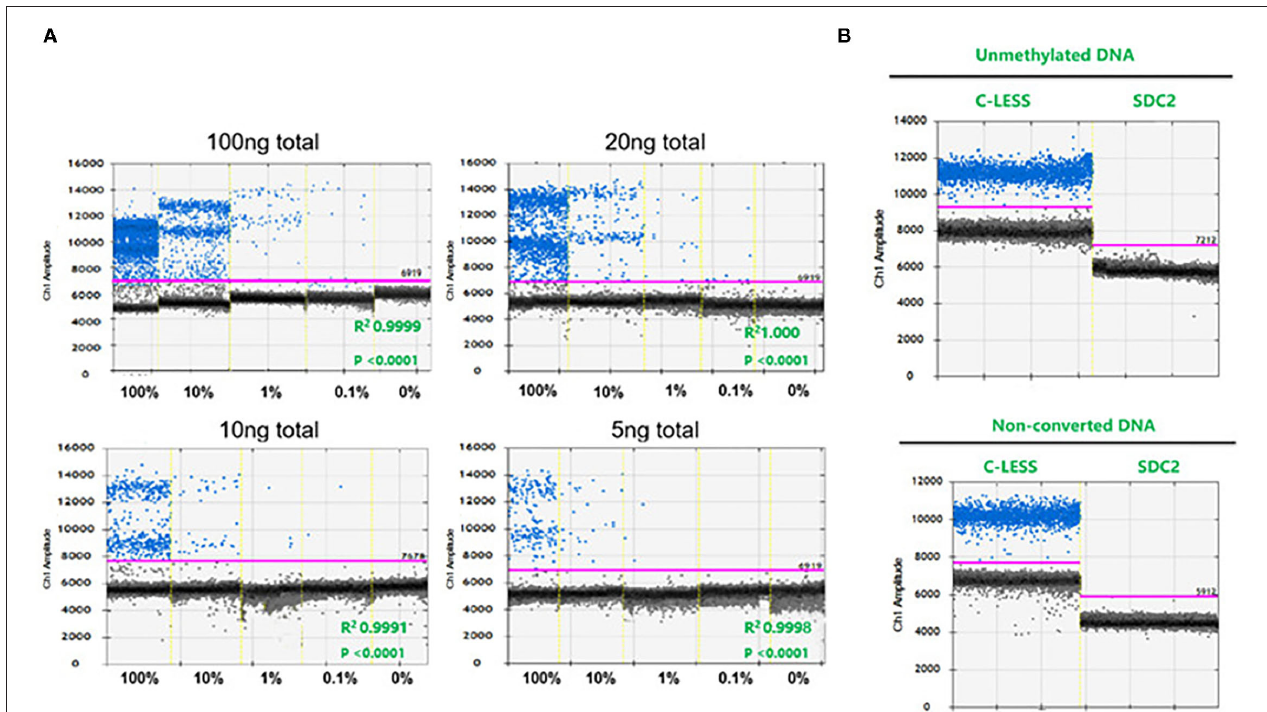
FIGURE 1 | The sensitivity, specificity, and analytical range of the SDC2 gene methylation by droplet digital PCR (ddPCR) assay. (A) Serial 1:10 dilution of bisulfite-converted fully methylated control DNA ( n = 3 independent replicates). (B) Unmethylated control DNA and non-converted DNA. 95% CI . Statistical heterogeneity was assessed by I 2